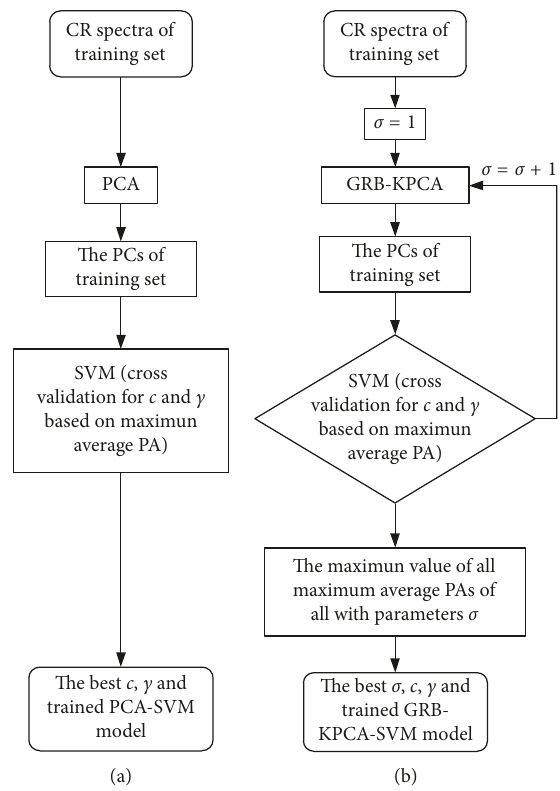
Figure 4: Flowcharts of procedures of PCA-SVM (a) and GRB-KPCA-SVM (b) models.